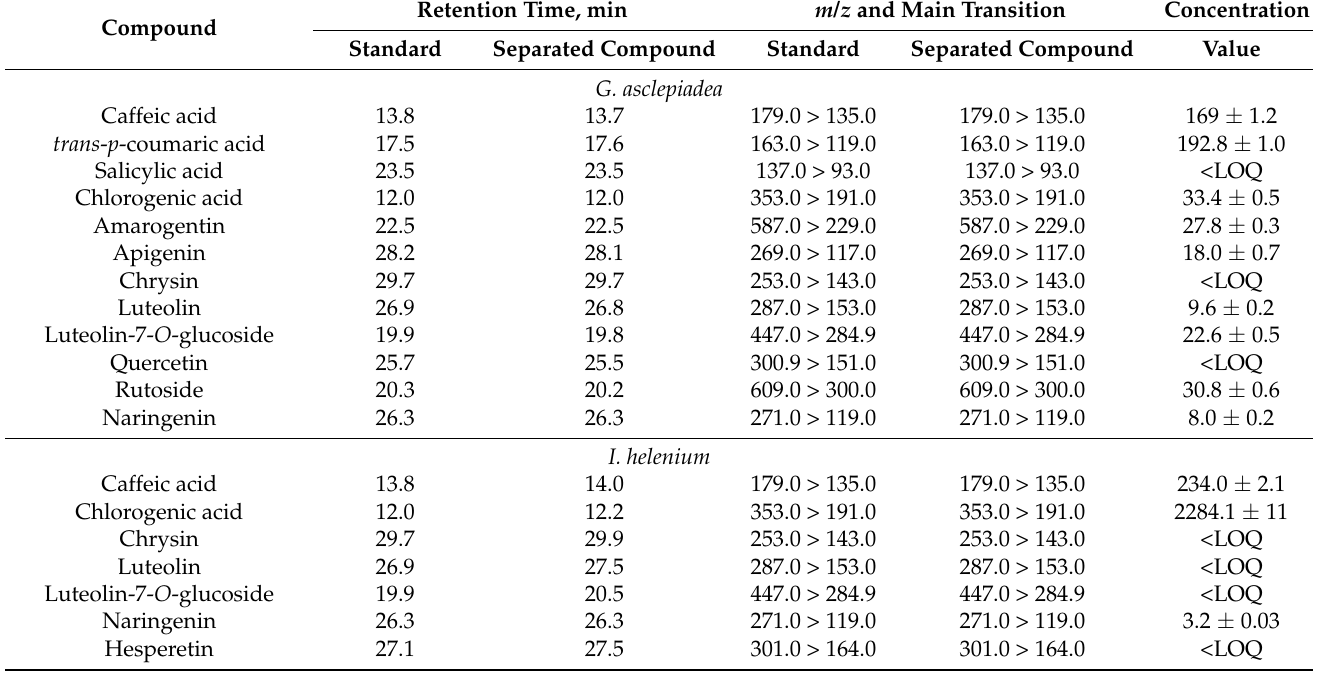
Table 2. The identified and quantified components in the G. asclepiadea and I. helenium root ethanolic extracts ( µ g/g dry vegetal material) by the LC-MS